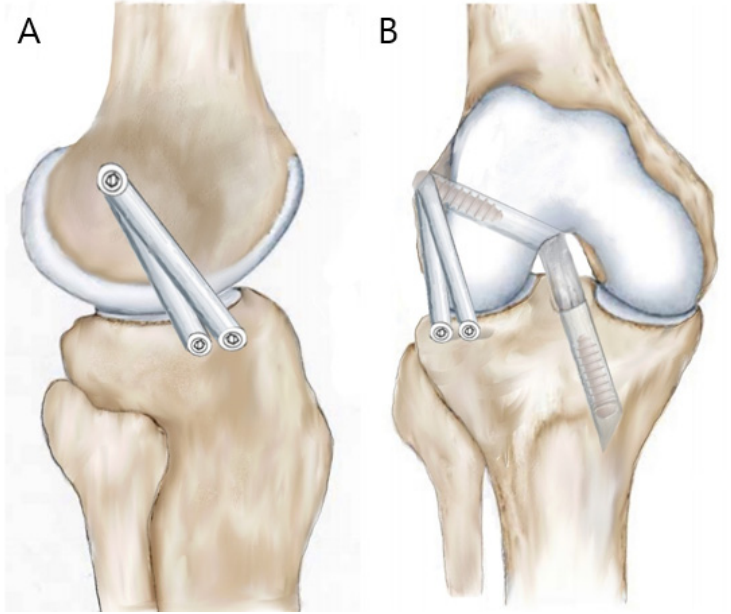
Figure 4. Schematic illustration of combined ACL and ALL reconstruction using a single Achilles tendon allograft shown in lateral ( A ) and frontal views ( B ).